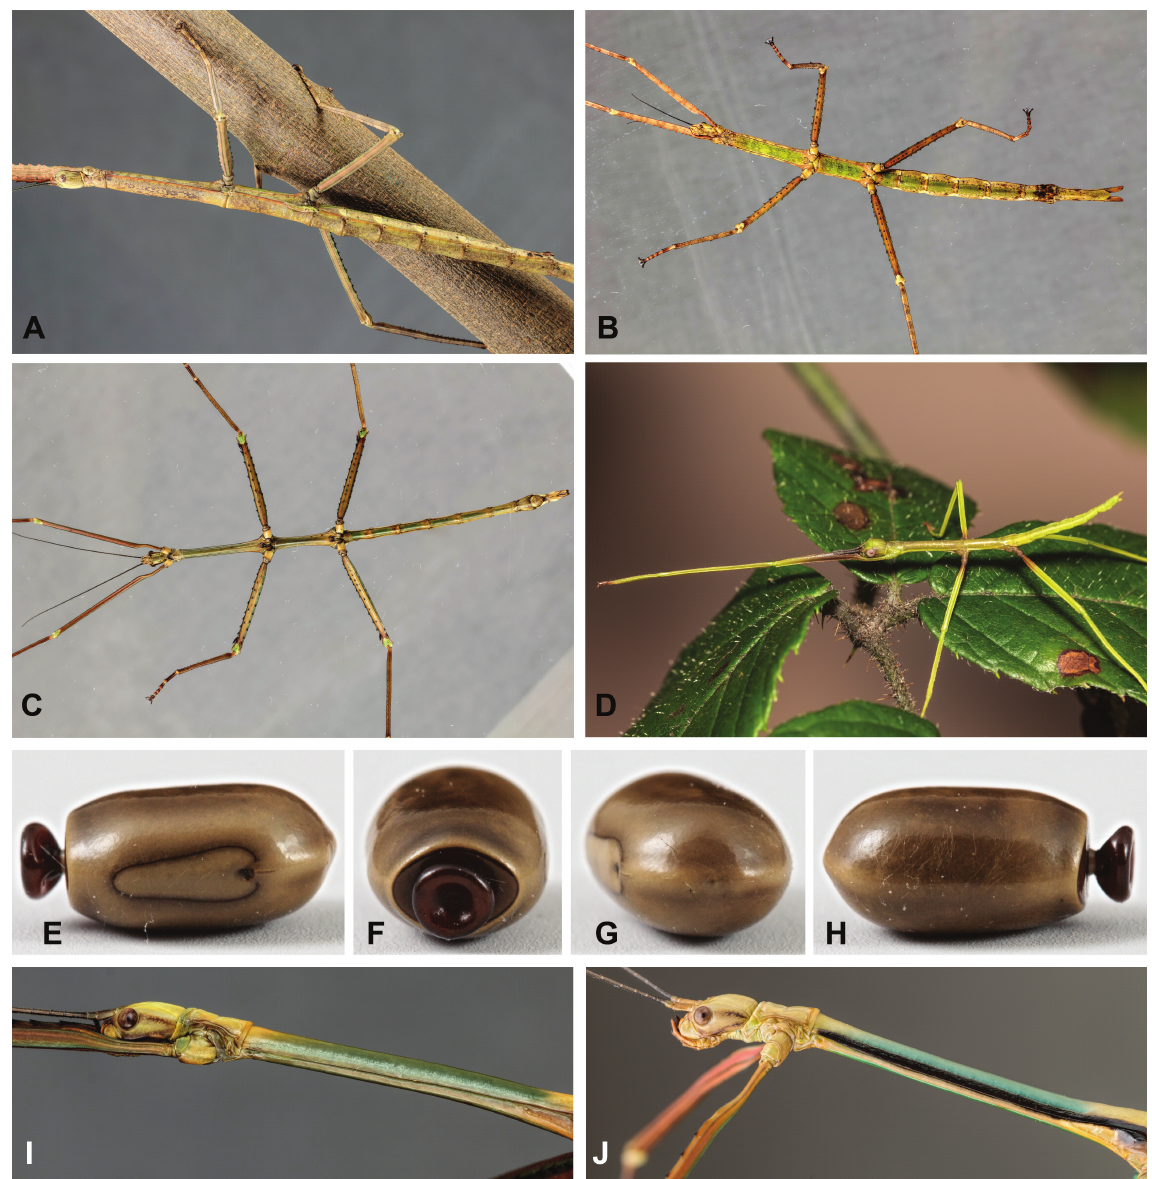
Fig. 7. Phryganistria tamdaoensis sp. nov. (photographs by Dr Bruno Kneubühler). — A–I . Captive reared, from Da Krong N.R. A . ♀, lateral view. B . ♀, ventral view. C . ♂, ventral view. D . Freshly hatched nymph. — E–H . Egg. E . Dorsal view. F . Detail of operculum and capitulum. G . Polar area. H . Ventral view. — I . ♂, head, pro- and mesothorax, lateral view. — J . Captive reared from Tam Dao N.P., ♂, head, pro- and mesothorax, lateral